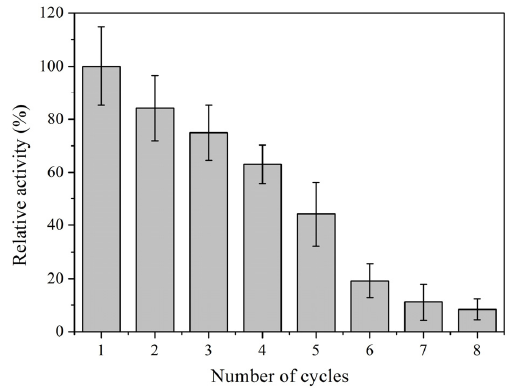
Figure 8. Relative activity of immobilized enzyme in the hydrolysis of p -NPC8 for different